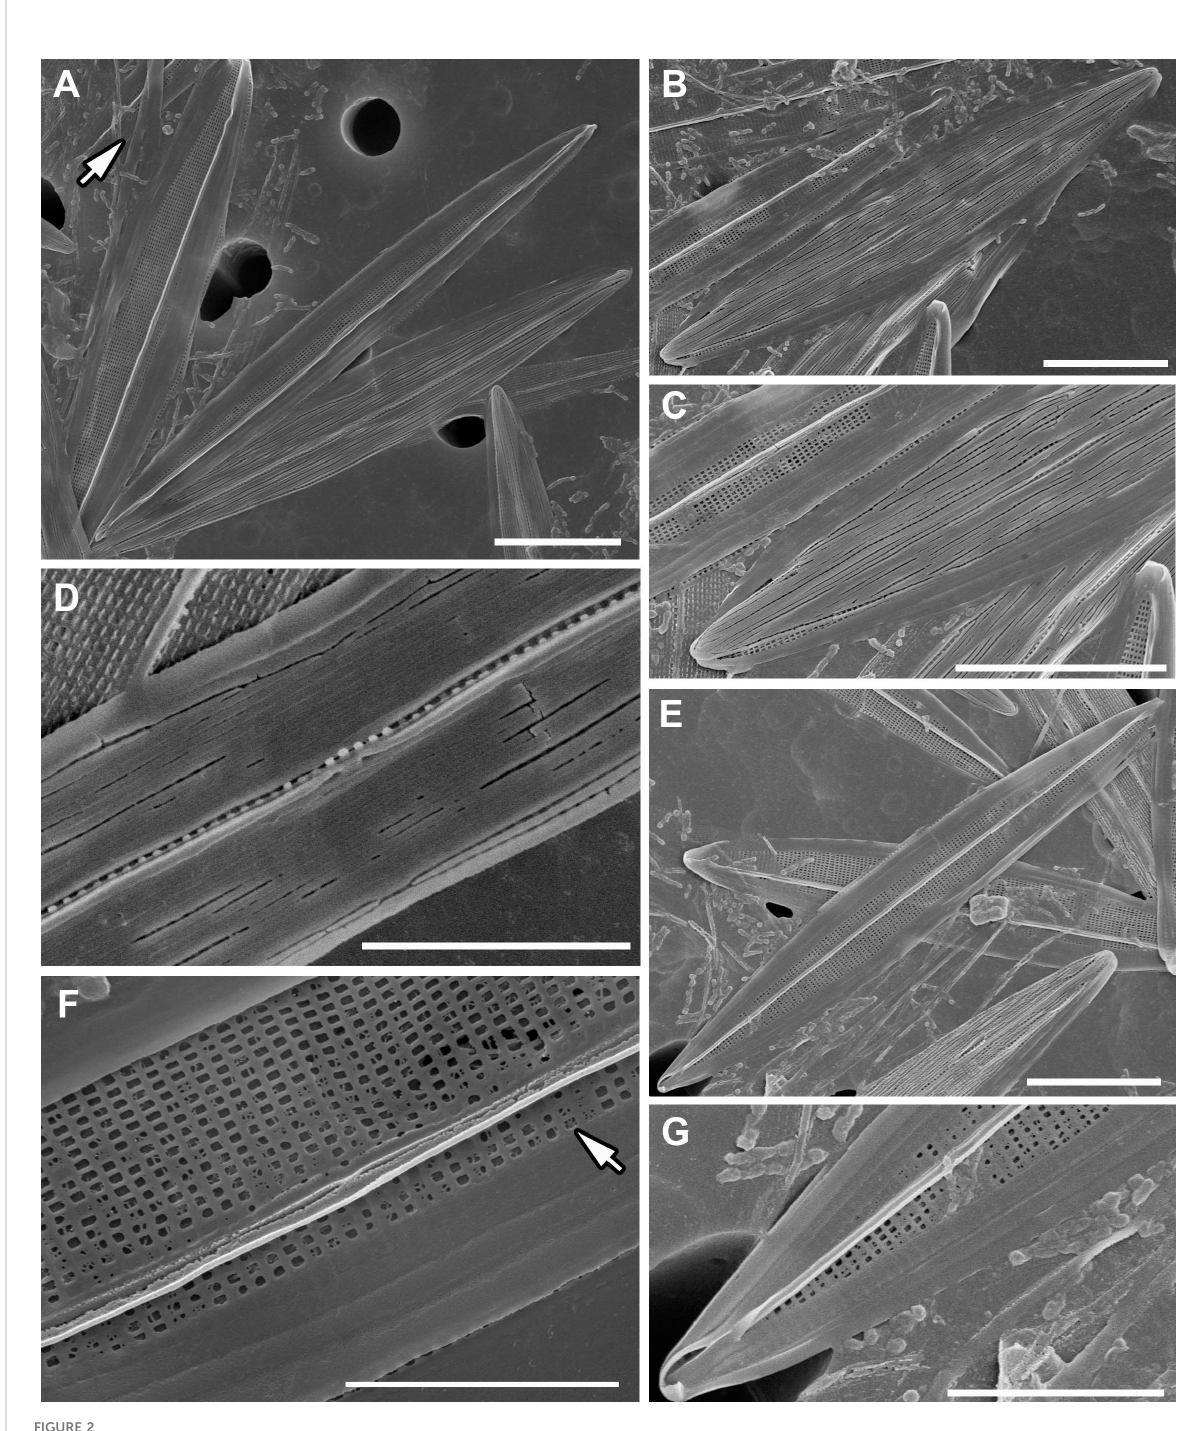
FIGURE 2 SEM images of H. ostrearia SZCZP1883. (A) General view of the bi-layered ( ‘ sandwich-like ’ structure) valves of Haslea ostrearia . Note the hyaline girdle bands (arrow). Scale bar = 10 m m. (B) External valve view with top layer composed of siliceous stripes. Scale bar = 10 m m. (C) Central and apical raphe ending from exterior. Scale bar = 10 m m. (D) Detailed view of a narrow central area of the valve exterior. Note the cracks exposing grate-like basal layer. Scale bar = 5 m m. (E) Internal valve view with basal layer composed of rectangular areolae. Scale bar = 10 m m. (F) Detailed view of central raphe ending and pattern of grate-like layer. Note the remnants of occlusions (arrow). Scale bar = 5 m m. (G) Apical raphe ending with helictoglossa from interior. Scale bar = 5 m